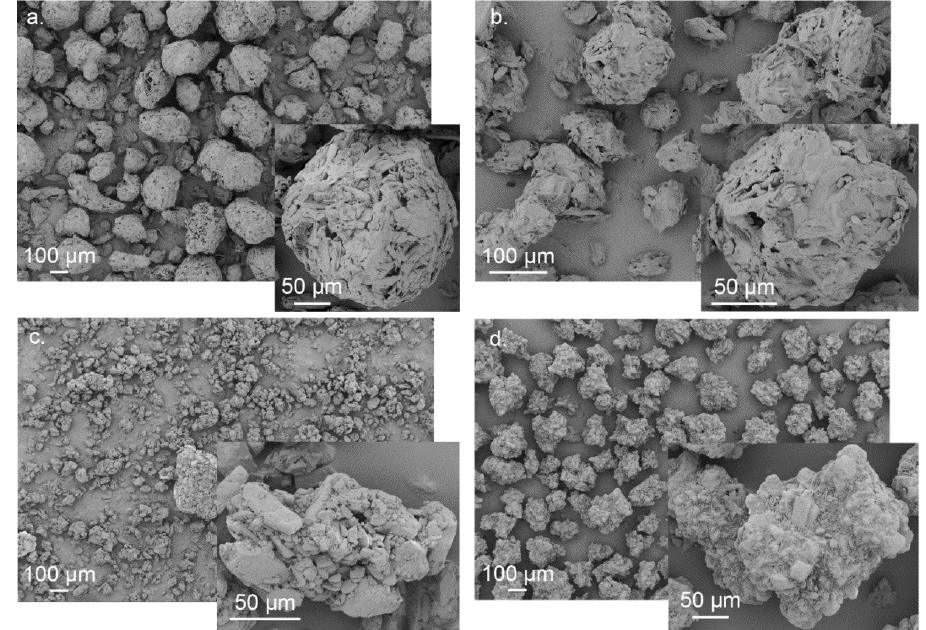
Figure 4. SEM acquisitions of the excipient powders prior to compaction: ( a ) MCC-A; ( b ) MCC-P; ( c ) LAC; ( d ) CAPH. MCC-A: Avicel ® PH 200 (FMC BioPolymer, Philadelphia, PA, USA); MCC-P: